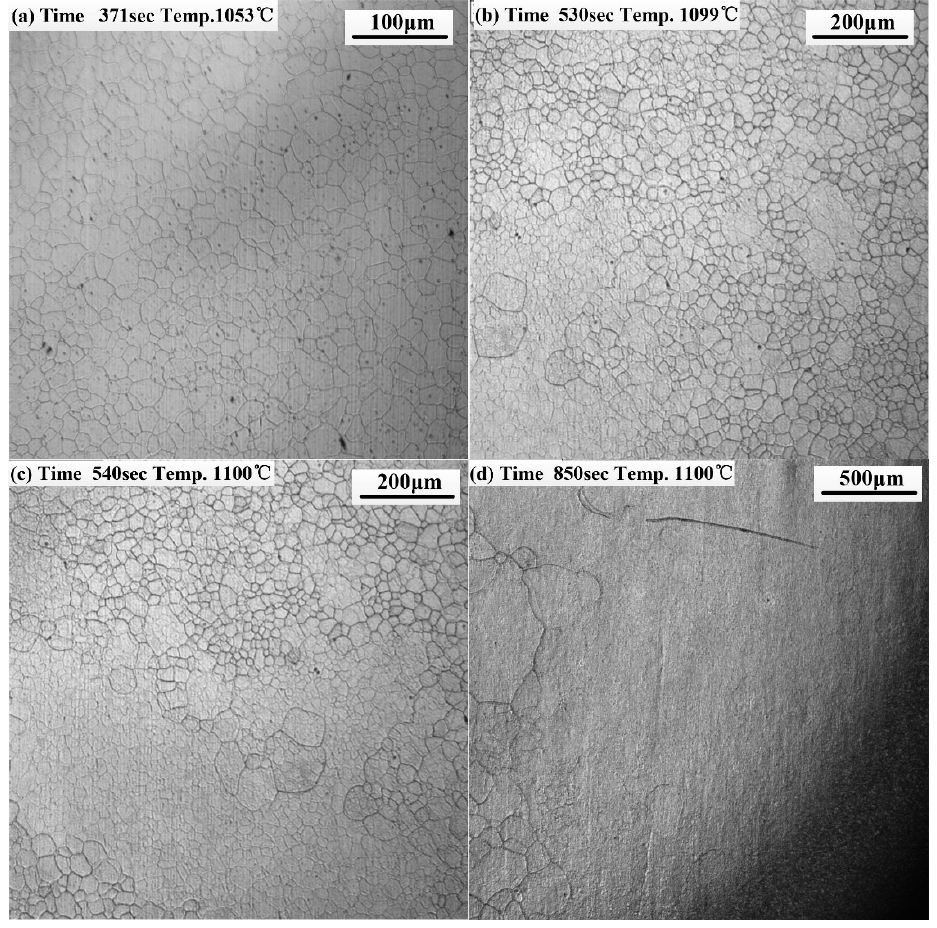
Figure 6. Microstructure evolution of strong inhibition specimens during secondary annealing by CLSM (intermediate annealed for 2 h). ( a ) 371 s; ( b ) 530 s; ( c ) 540 s; ( d ) 850 s.